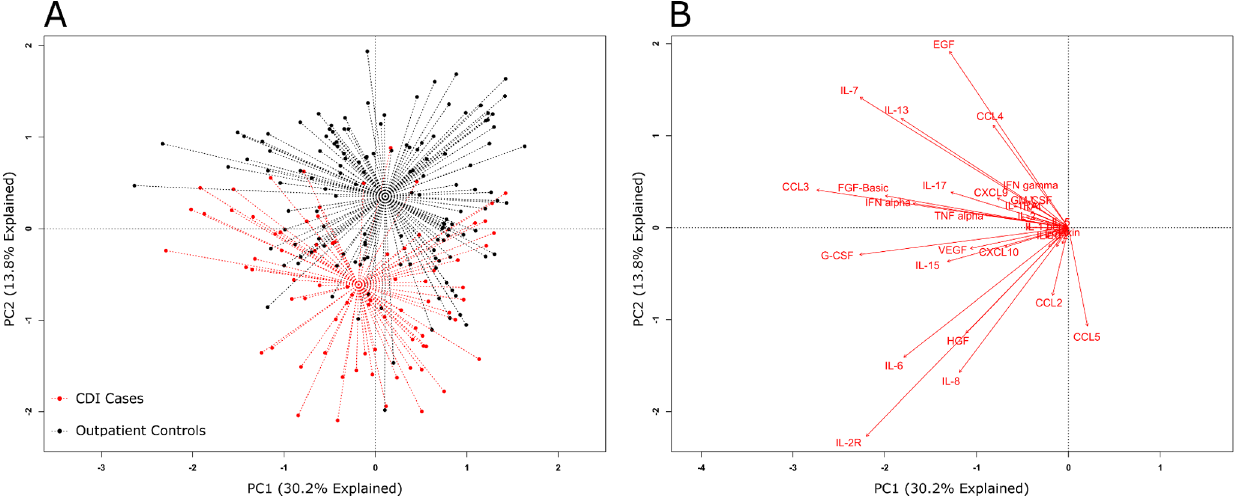
Figure 4. Global systemic inflammatory responses in C.difficile infection (CDI) cases and outpatient controls. Principal component analysis (PCA) (panel A) results are shown for CDI cases and outpatient controls. The individual inflammatory mediators’ effects on the PCA were plotted as biplots (panel B). In biplots the arrows indicate the direction of maximum change while the length of arrows represents the magnitude of the change. The PCA centroids were different by permutational MANOVA testing ( P , .001).